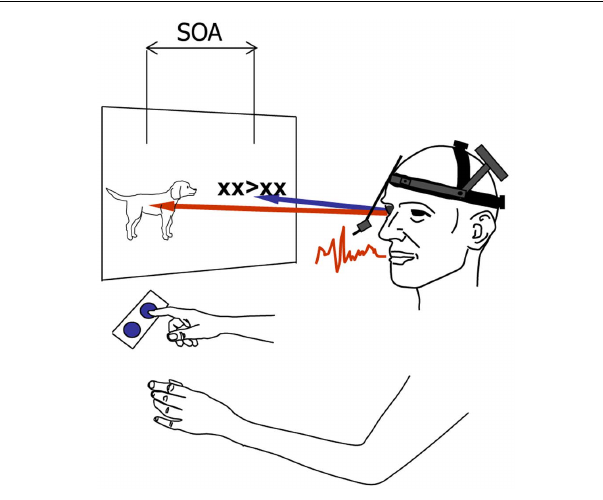
FIGURE 2 | Schematic illustration of the experimental set-up used in the eye tracking study of Roelofs (2008a). On each trial, participants named a picture and shifted their gaze to a left- or right-pointing arrow to manually indicate its direction by pressing a left or right button. Picture and arrow were presented at stimulus onset asynchronies (SOAs) of 0, 300, or 1000ms.The latencies of vocal responding, gaze shifting, and manual responding were recorded.